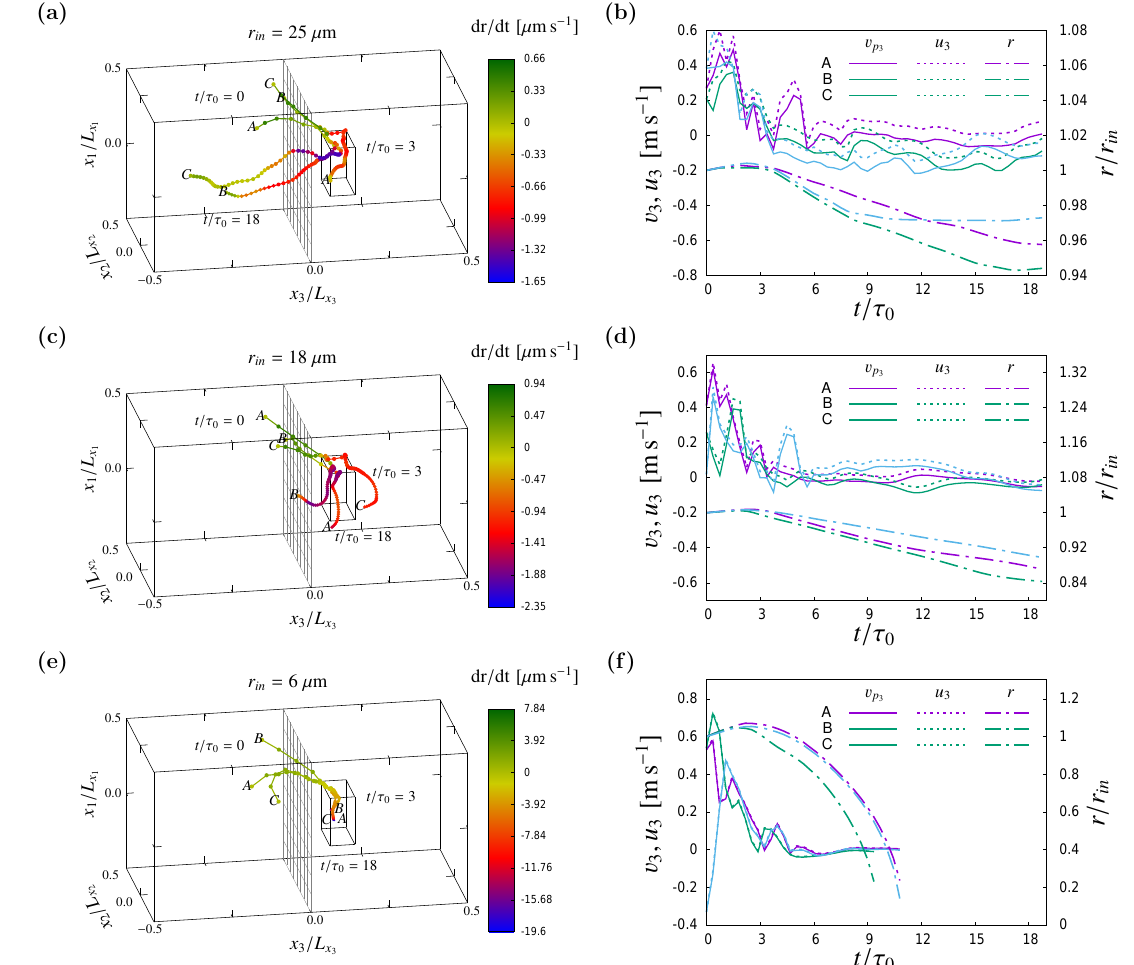
Figure 10. Lagrangian trajectories: A sample of few individual cloud droplet trajectories. ( a , c , e ) visualization of the time evolution of droplet positions; and ( b , d , f ) Lagrangian history of the vertical component of droplet velocity v 3 , fluid velocity at that droplet position u 3 and their normalized droplet radius r / r in up to the end of simulation duration ( t / τ 0 = 18) or to the end of the droplet life till being completely evaporated (panels e and f ) are presented. Colourbar for the left panels represents droplet radius growth rate d r /d t , thus indicating the droplet positions where condensation or evaporation occur. Size of the droplets are proportional to normalized droplet radius r / r in